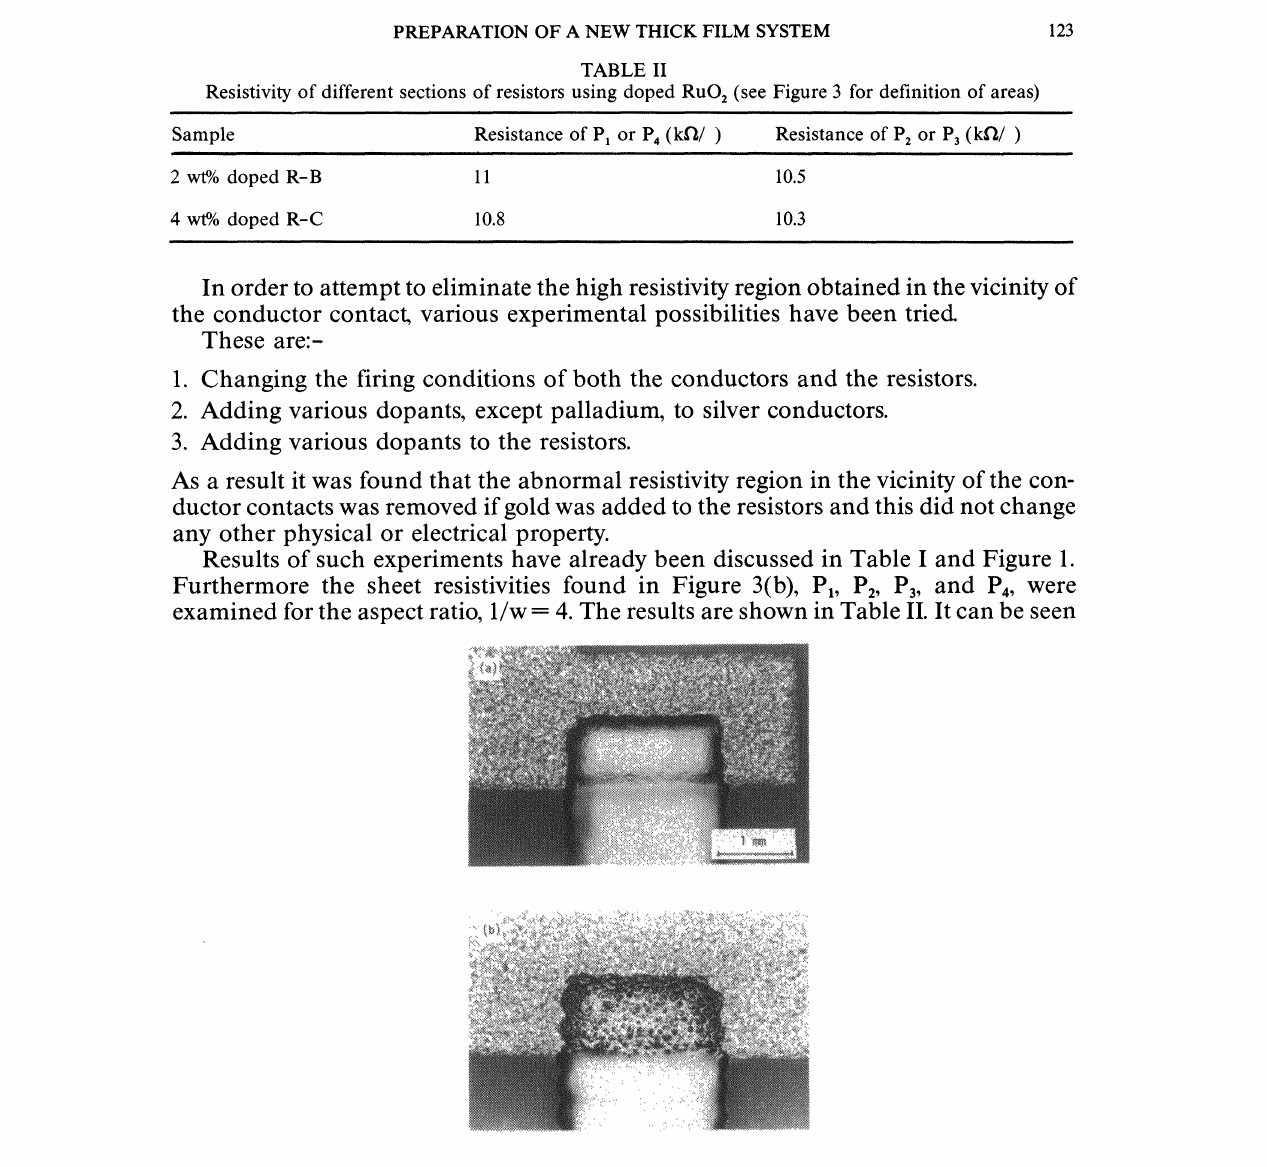
FIGURE 4 Optical micrographs of conductor-- resistor overlap areas. (a) Ag/RuO (b) Ag/RuO + 2%Au, (c) Ag/RuO +